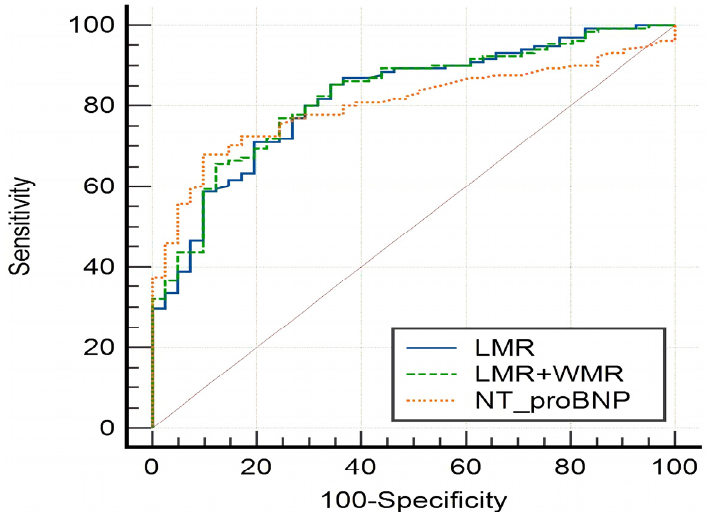
Figure 2. ROC curve analysis of LMR, NT-proBNP and LMR combined with WMR.